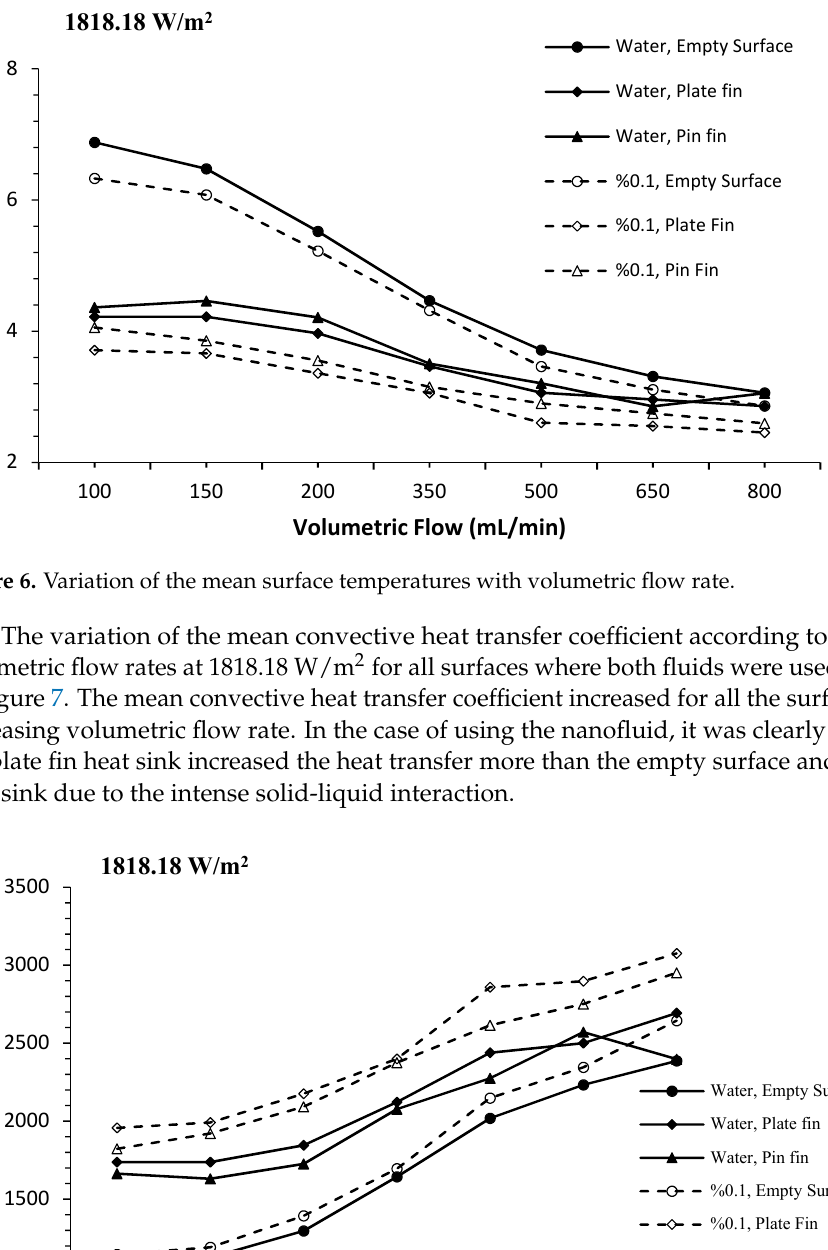
decrease further. It was also observed that these temperature values approached each other with the increasing volumetric flow rate.